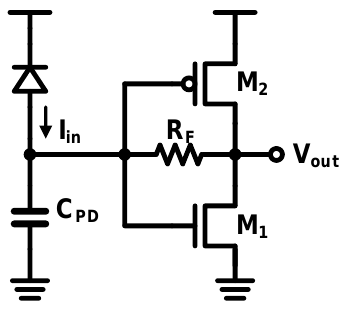
Figure 27. Inverter-based TIA.